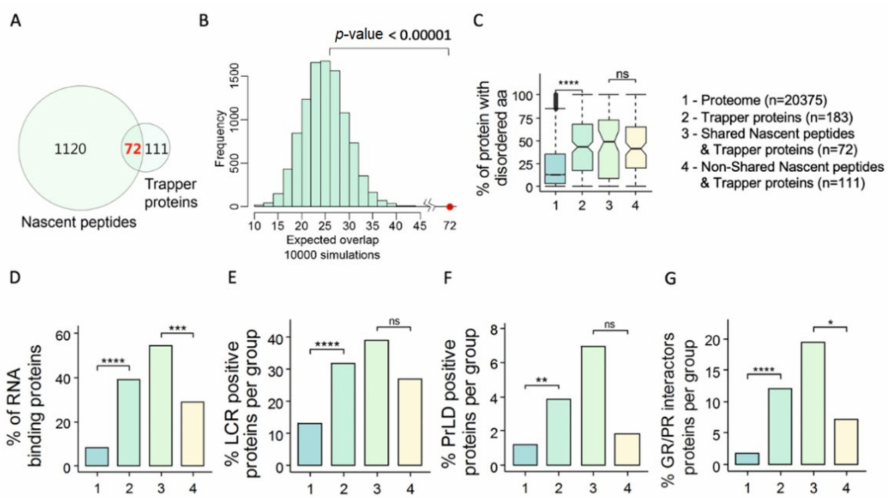
Figure 6. Many of the PSMA3 trapper-binding proteins (TBPs) are proteasomal associated in the cells ( A ) Venn diagram of the nascent proteasome substrates (nascent peptides, 1192 proteins) and the PSMA3–BPs (trapper). ( B ) The expected overlap between the two groups in Panel A was evaluated by a Z-test with the null distribution calculated by 10,000 simulations. The expected average